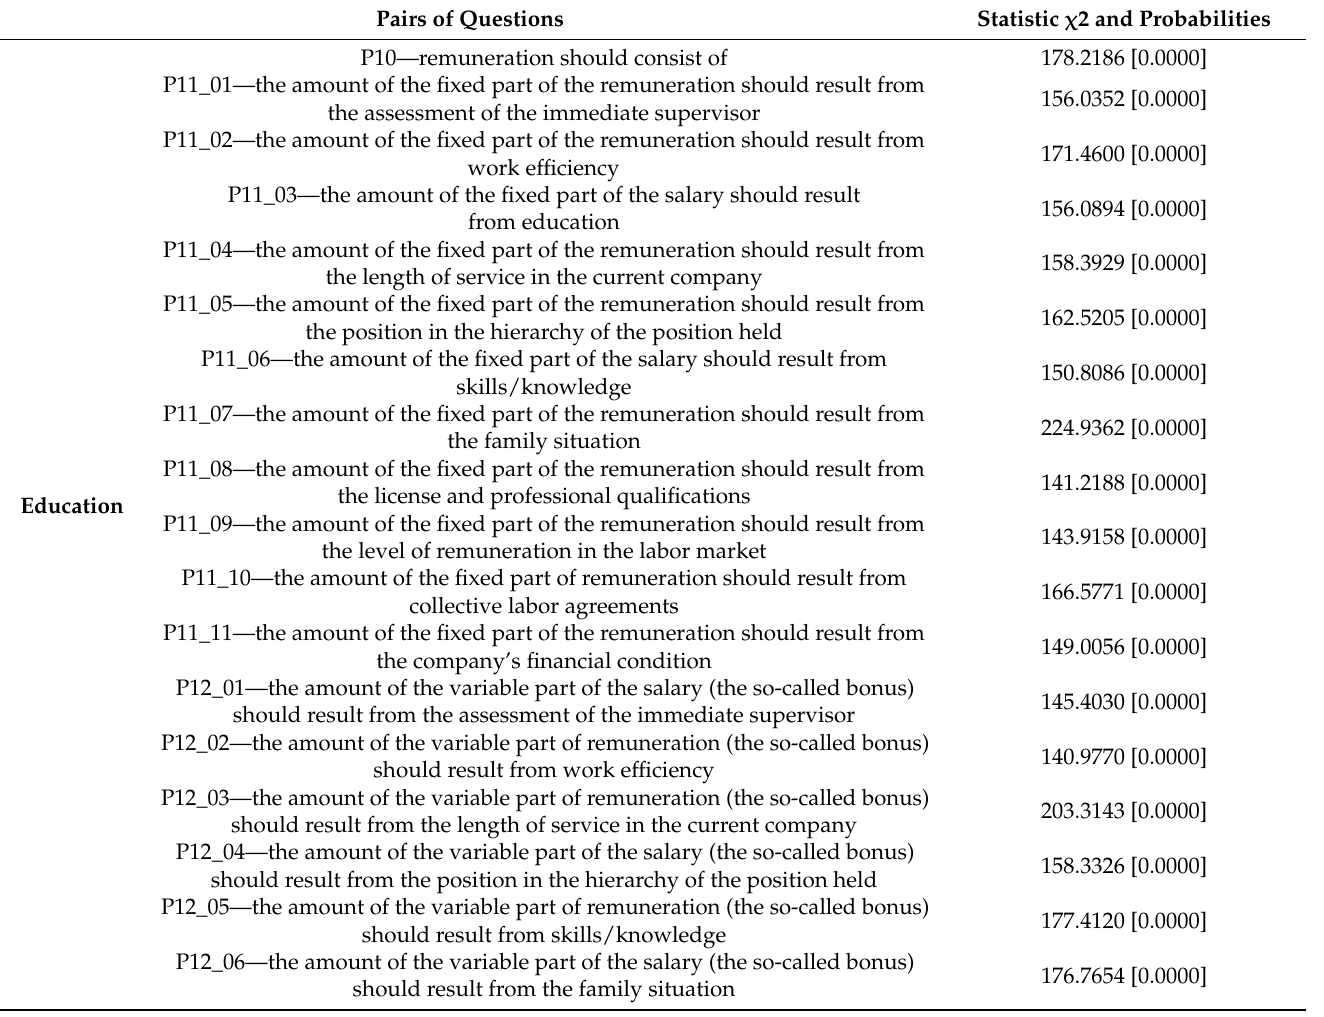
Table 3. The statistic value χ 2